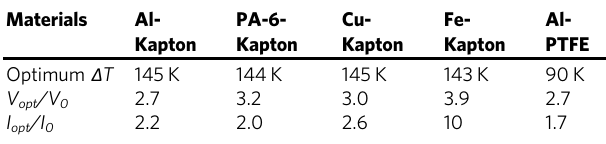
( V opt and I opt are the open-circuit voltage and short-circuit current of the TDNGs at the optimal Δ T , respectively. V 0 and I 0 are the open-circuit voltage and short-circuit current of the TDNGs when Δ T equals 0K,